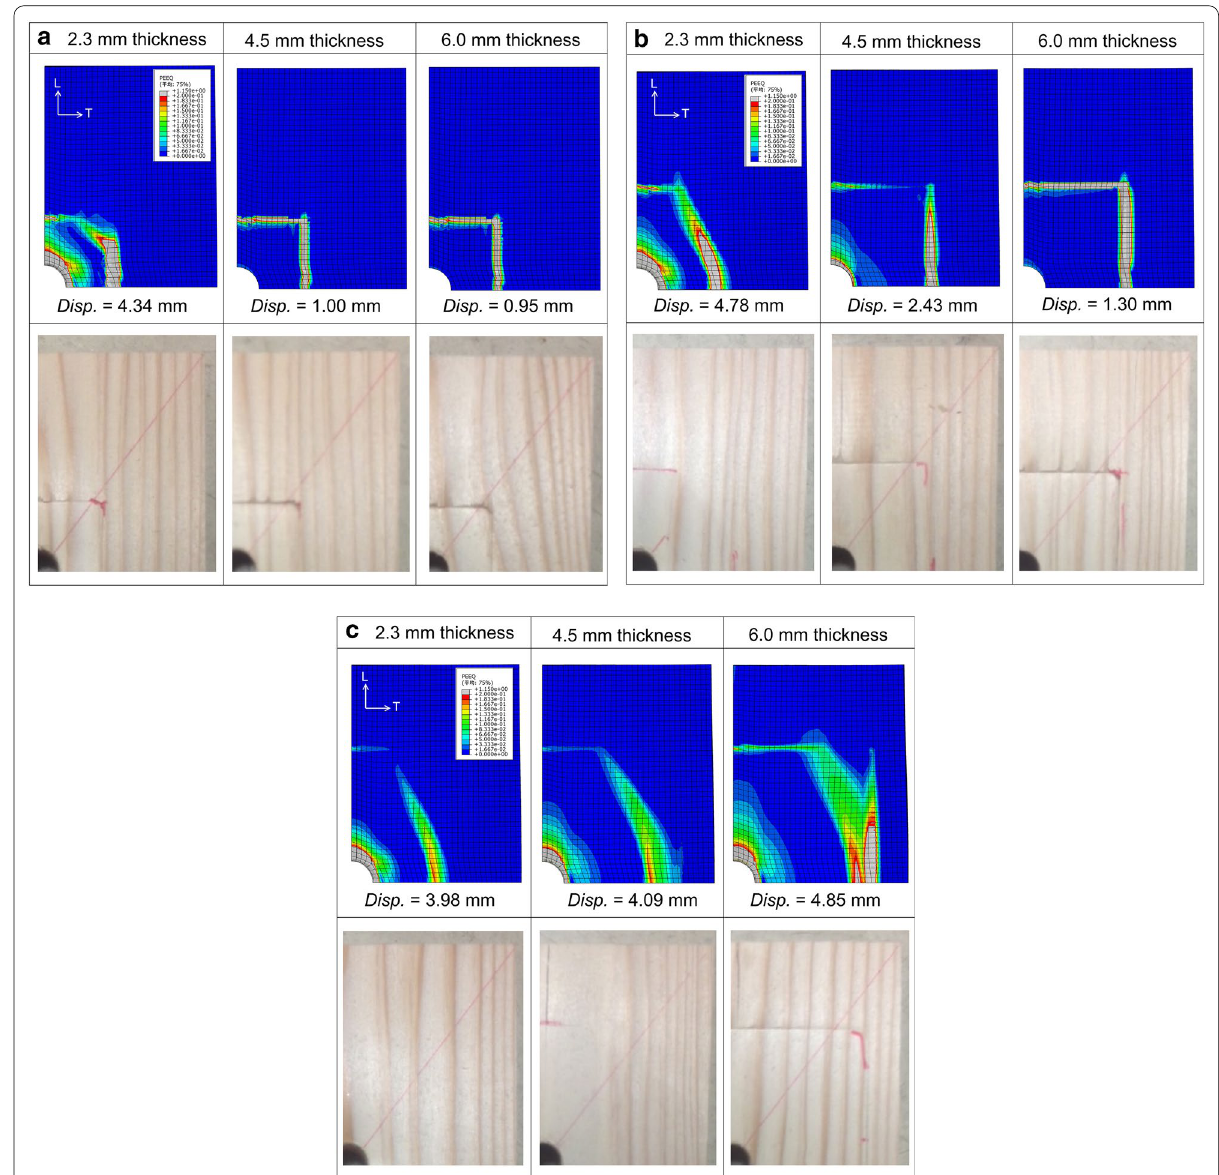
Fig. 4 Residual displacement of wood after embedment test is finished, and distribution of equivalent plastic strain of wood in the LT (L: longitudinal, T: tangential) plane at the final step of FEA. Side lengths of metal washers are ( a ) 40, ( b ) 60, and ( c ) 80